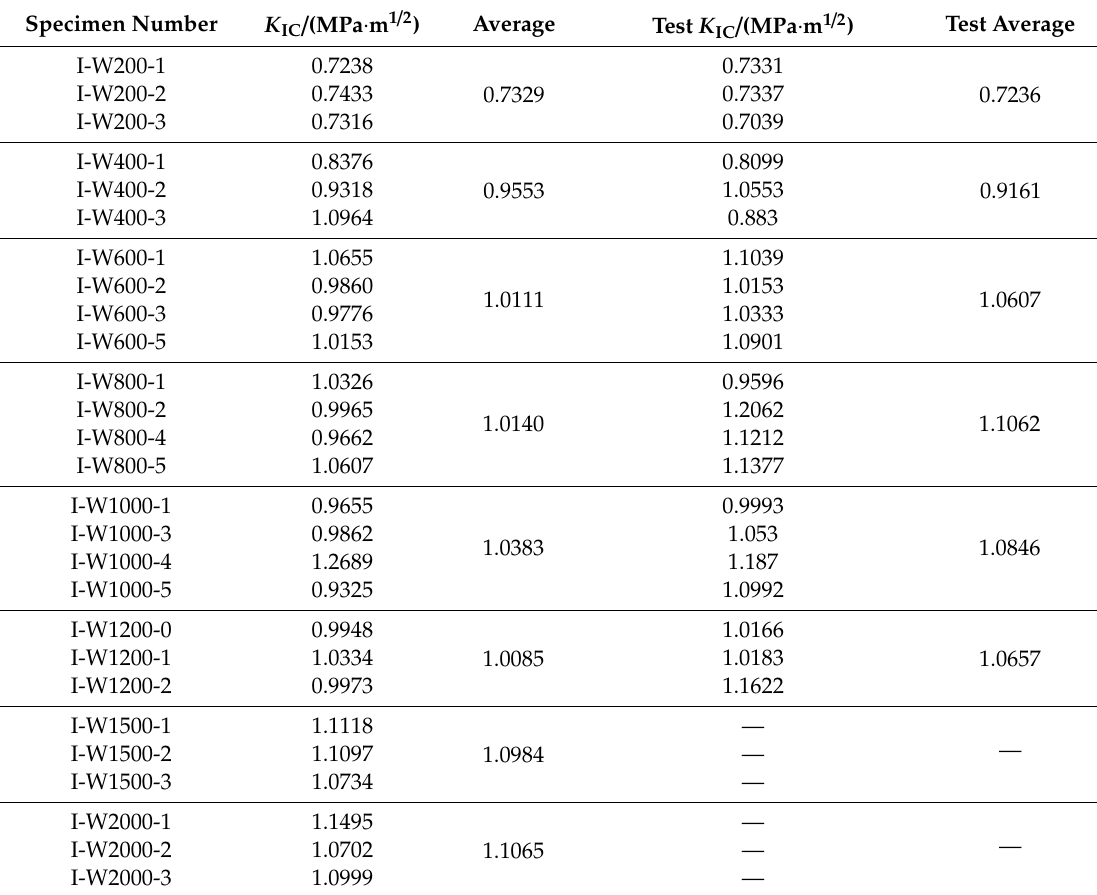
Table 5. Fracture toughness ( K IC ) calculation